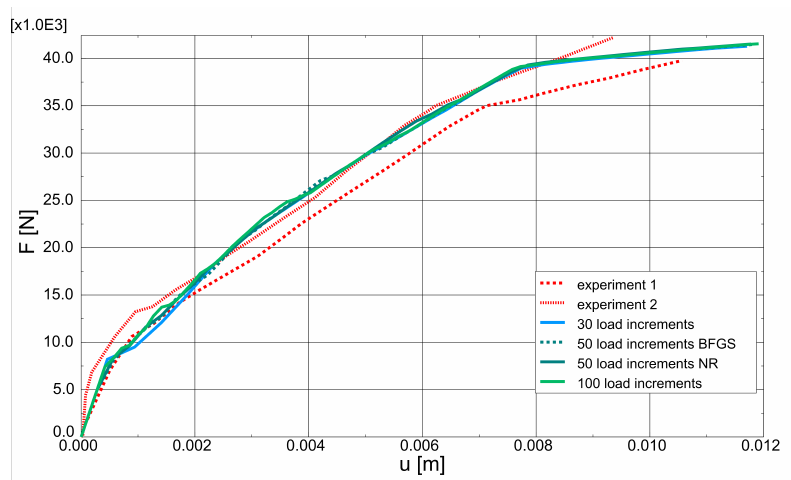
Figure 19. Beam failure in bending—influence of Newton-Raphson parameters.